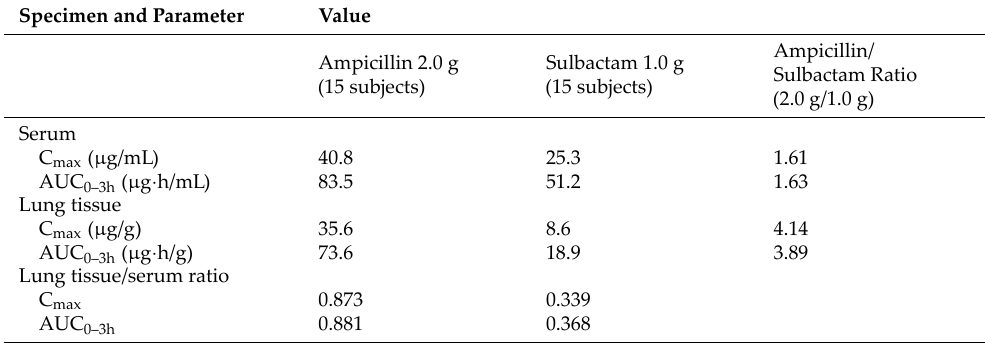
Table 1. Calculation of lung tissue/serum ratio and ampicillin/sulbactam ratio in the lung tissue. Specimen and